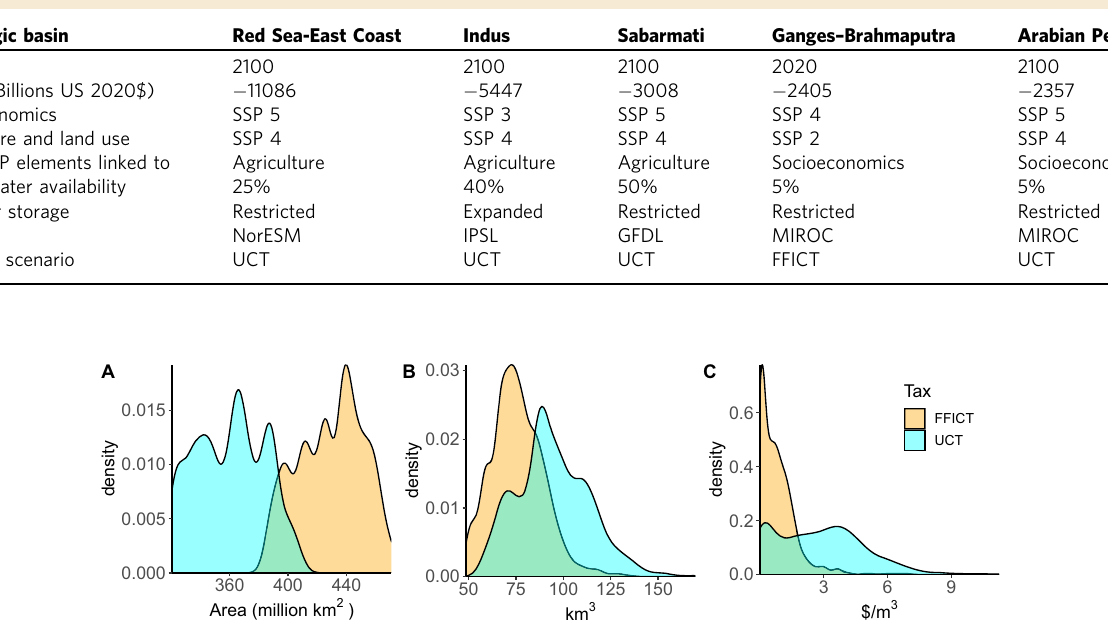
Fig. 3 Land use scenario impacts. Density plots depicting the difference in tax regimes. The plot in A depicts the sum of global cropland over time under the two carbon tax regimes. The density plot in B shows water withdrawals in the Arabian Peninsula in FFICT (orange) and UCT (cyan) scenarios. The density plot in C depicts the shadow price of water in the Indus River basin in the two tax cases. Values in B and C are averaged over time. Total agricultural land increases under the FFICT while water price and water withdrawals increase under the